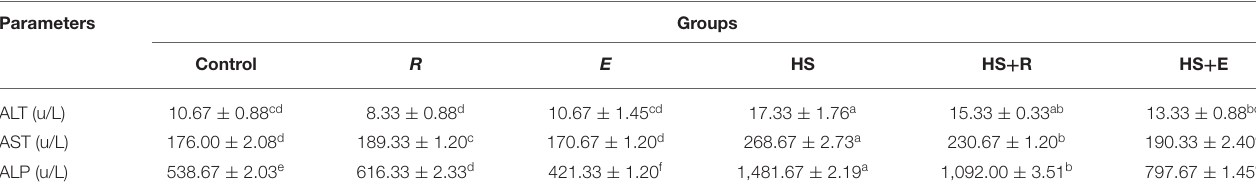
TABLE 6 | Effects of supplementation with digestive enzymes and/or Ruminococcus sp. on the liver enzyme activity of chickens’ blood serum at 42 days. Parameters